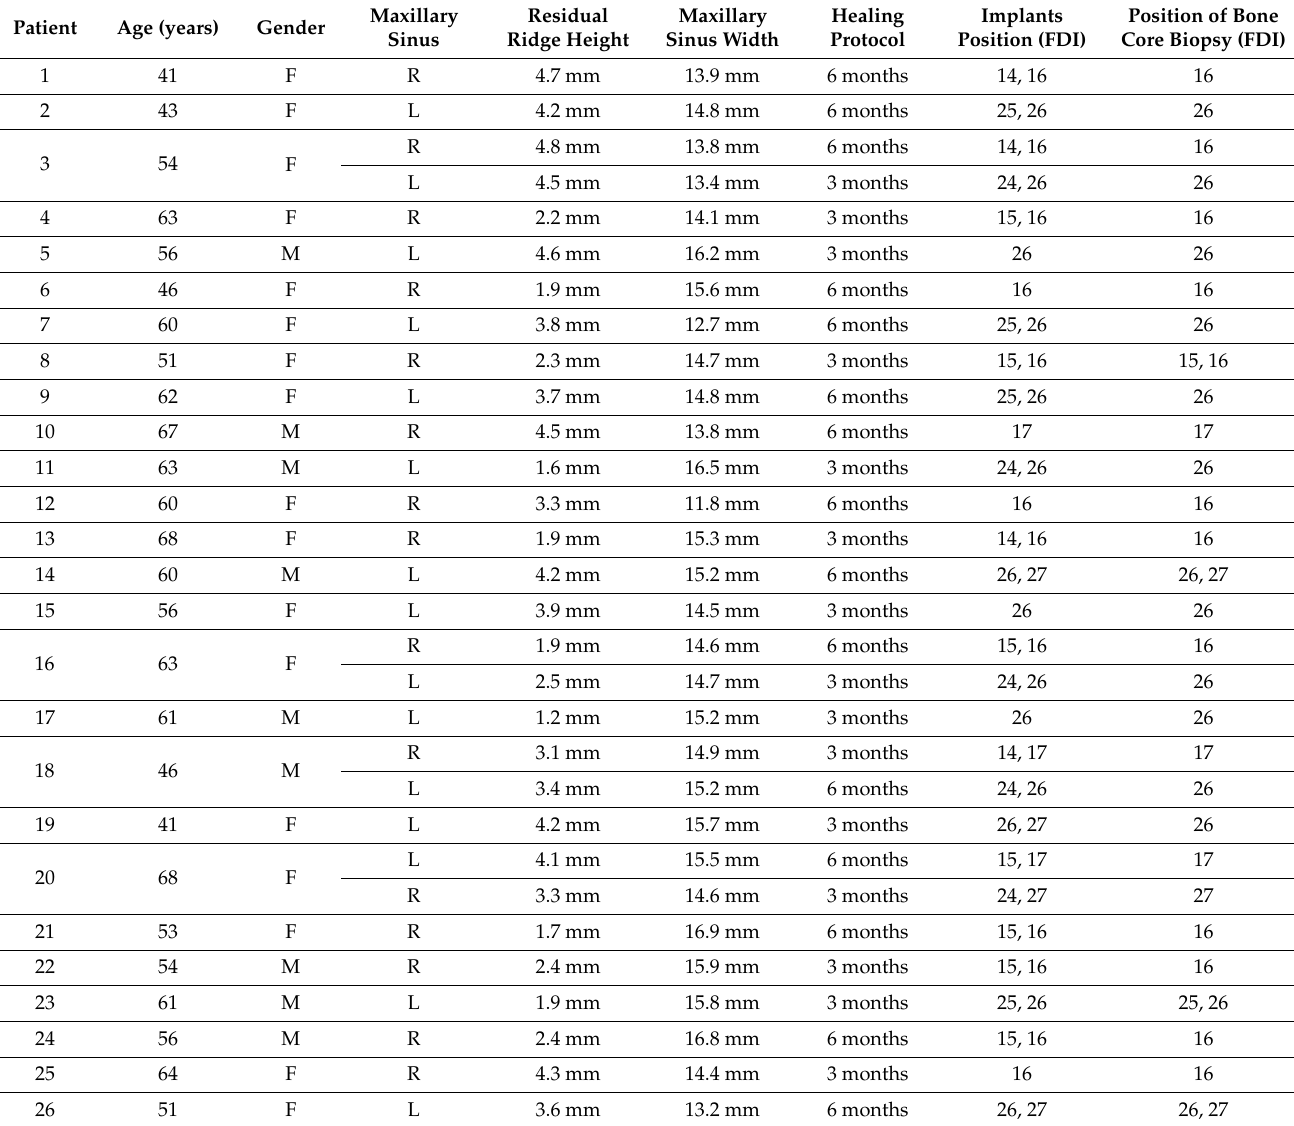
Table 2. Demographics and clinical data of the patients. Abbreviations: male (M), female (F), right (R), left (L).